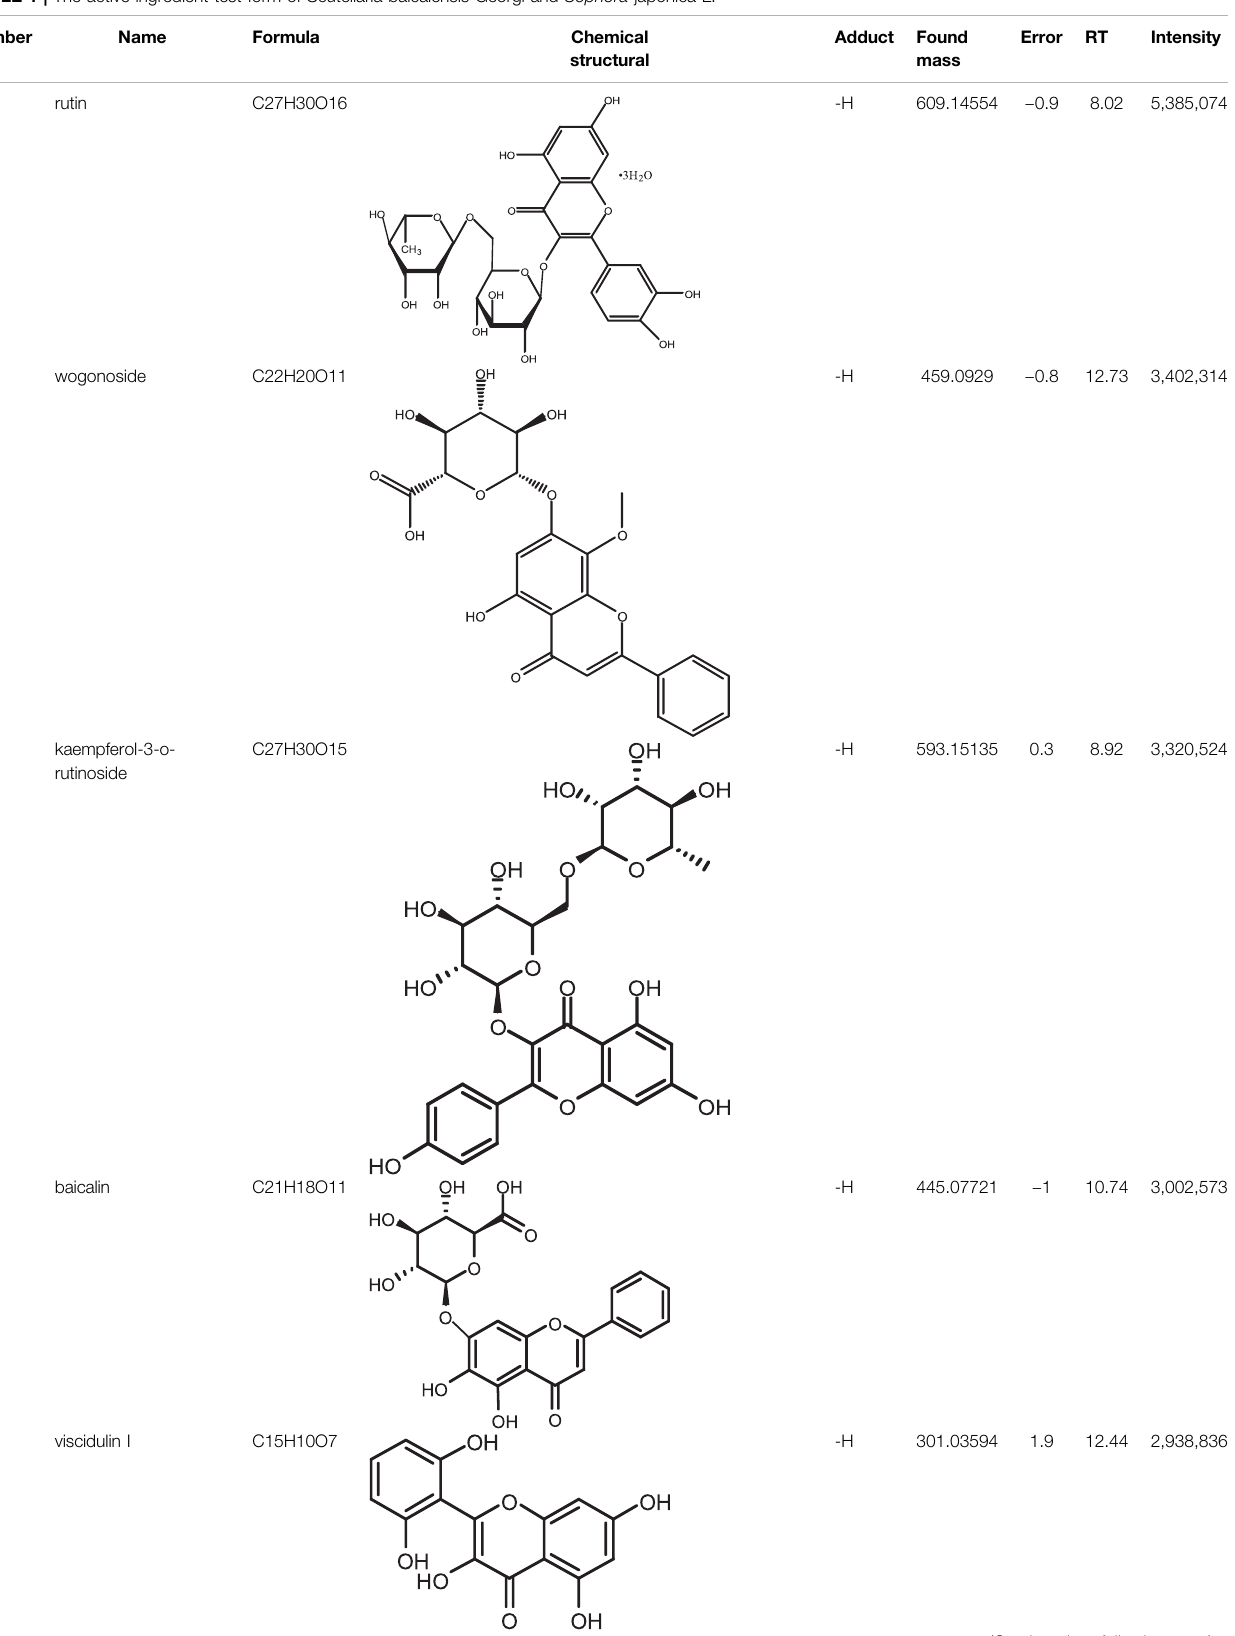
TABLE 1 | The active ingredient test form of Scutellaria baicalensis Georgi and Sophora japonica